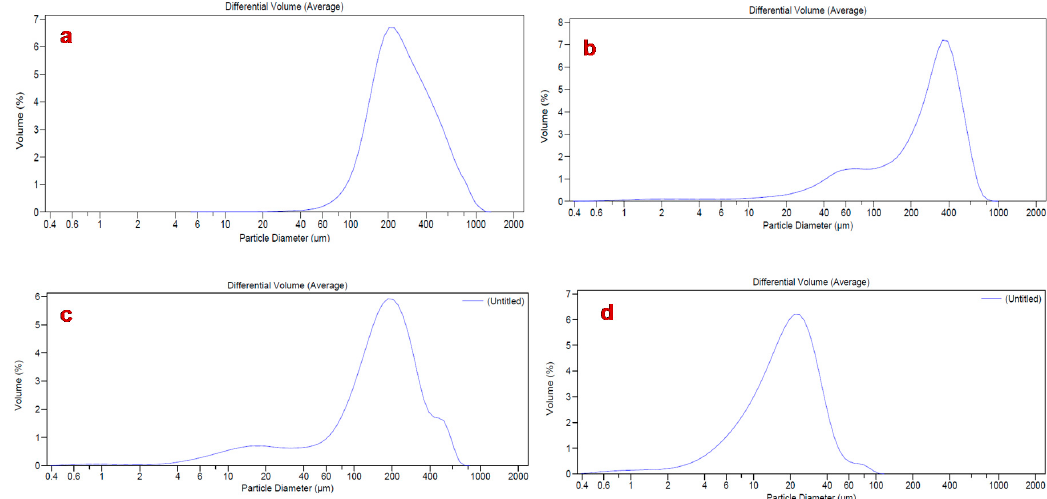
Figure 3. Size distribution analysis of L-proline ( a ), hydroxyethylcellulose (HEC) ( b ), AJ raw ( c ), and loaded powder (AJEP 3 , d ).